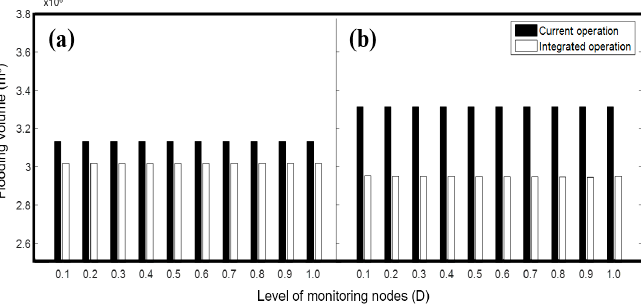
Figure 11. The results of current and integrated operations: ( a ) 2010; ( b ) 2011.